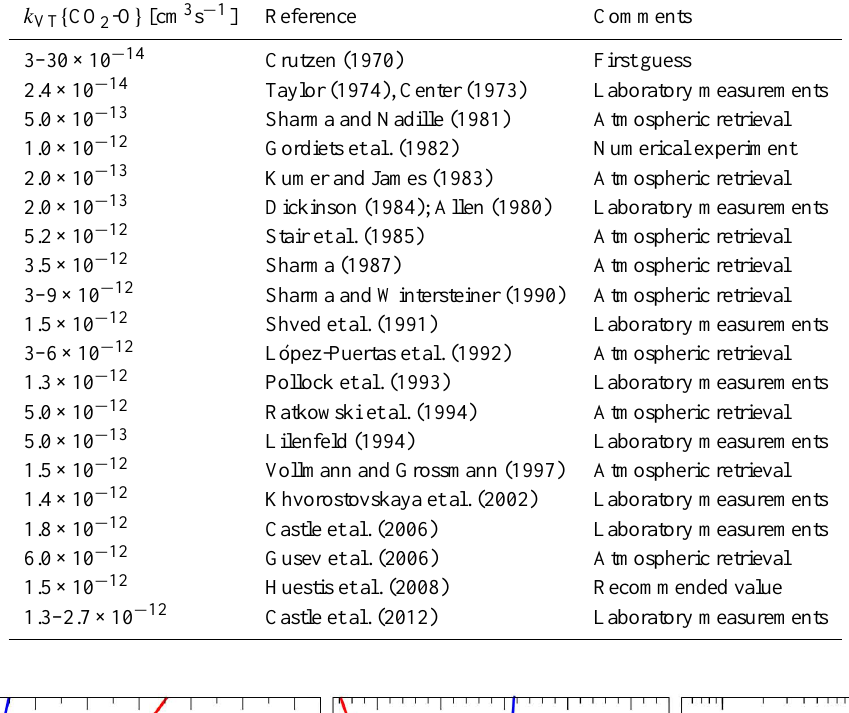
Table 1. Historical review of the k VT { CO 2 -O } quenching rate coefficient measurements and atmospheric retrievals at T = 300K.